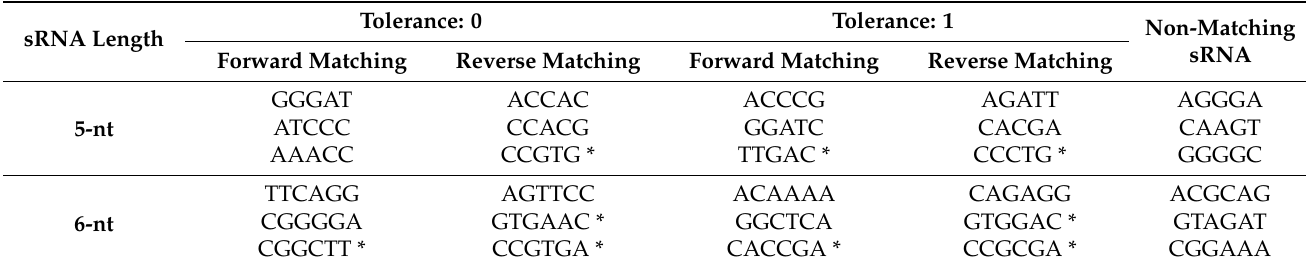
Table 1. Summary of the sRNA sequences used in the test run of the sRNA profiler.